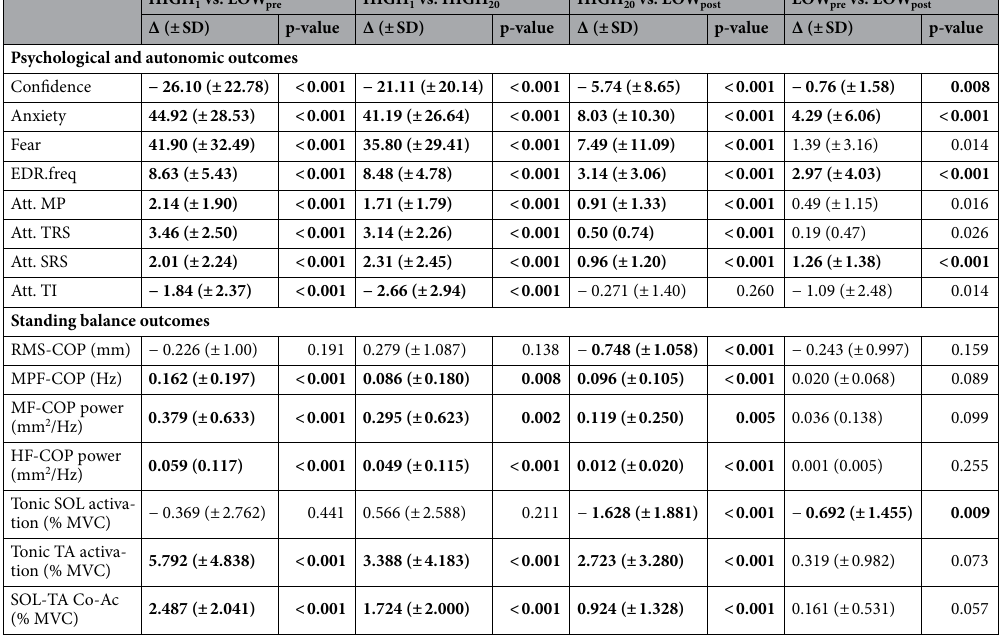
Table 3. Follow-up pairwise comparisons for significant threat × trial interactions for two-way RM-ANOVAs examining within-session habituation at visit 1. Mean differences (Δ) and p-values for each comparison are presented. EDR.freq: non-specific electrodermal response frequency; Att.: attention toward; MP: movement processes; TRS: threat-related stimuli; SRS: self-regulatory strategies; TO: task objectives; TI: task-irrelevant information; COP: centre of pressure; RMS: root mean square; MPF: mean power frequency; LF: low- frequency (0–0.05 Hz); MF: medium-frequency (0.5–1.8 Hz); HF: high-frequency (1.8–5 Hz); MVC: maximal voluntary contraction; SOL: soleus; TA: tibialis anterior; Co-Ac: coactivation. Significant comparisons after Bonferroni correction (alpha 0.0125) are